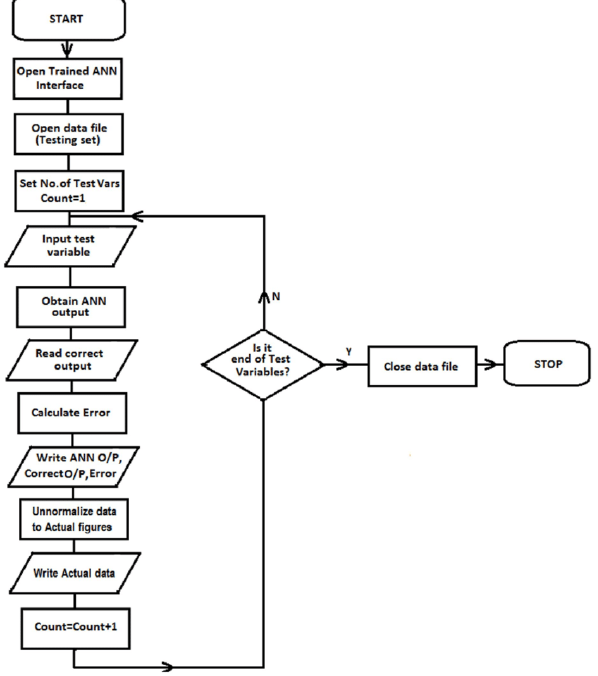
Figure 2. Flowchart for ANN Prediction model for KSE